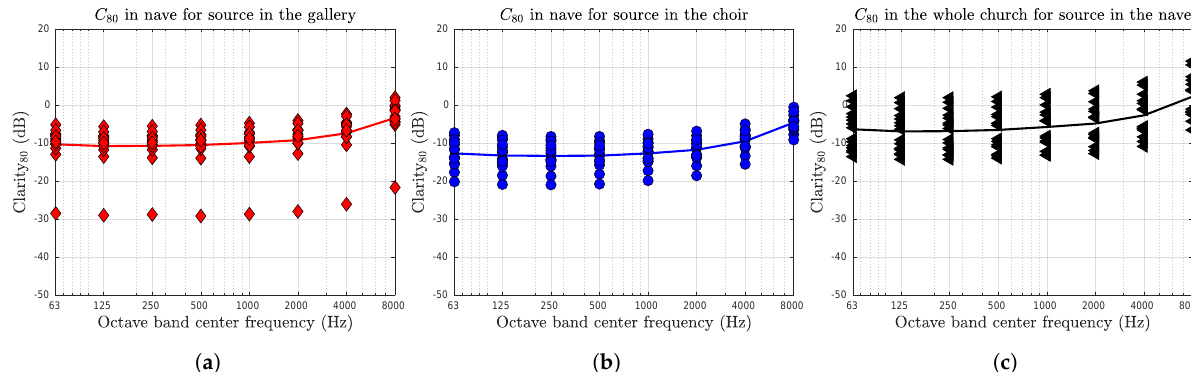
Figure 14. C 80 in octave bands simulated for the recreated church, shown for 13 different receiver positions. The spatial mean (line) is also shown. ( a ) C 80 when the sound source is located in the nuns’ gallery. One position produces significantly lower clarity. ( b ) C 80 when the sound source is located in the choir. ( c ) C 80 when the sound source is located by the high altar in the